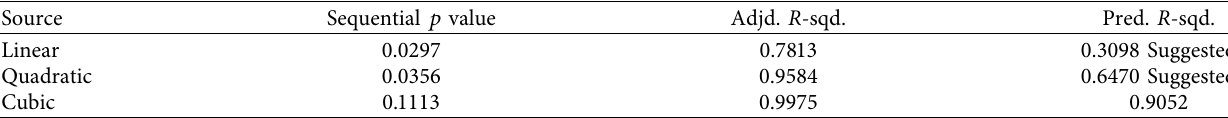
Table 13: Lack of fit for flexural strength response.